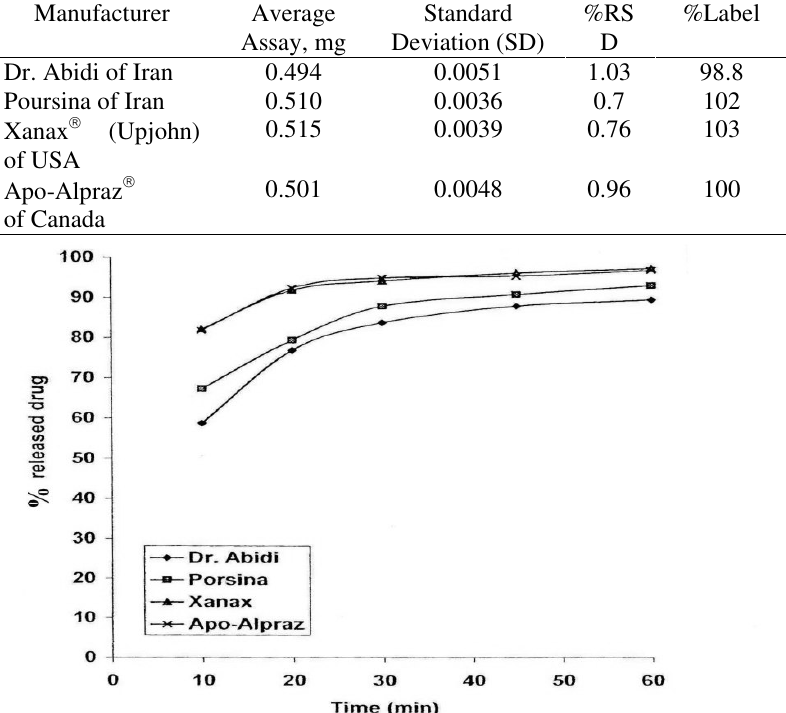
Table 6 . Determination of the active ingredient (assay) ( m g/mL)